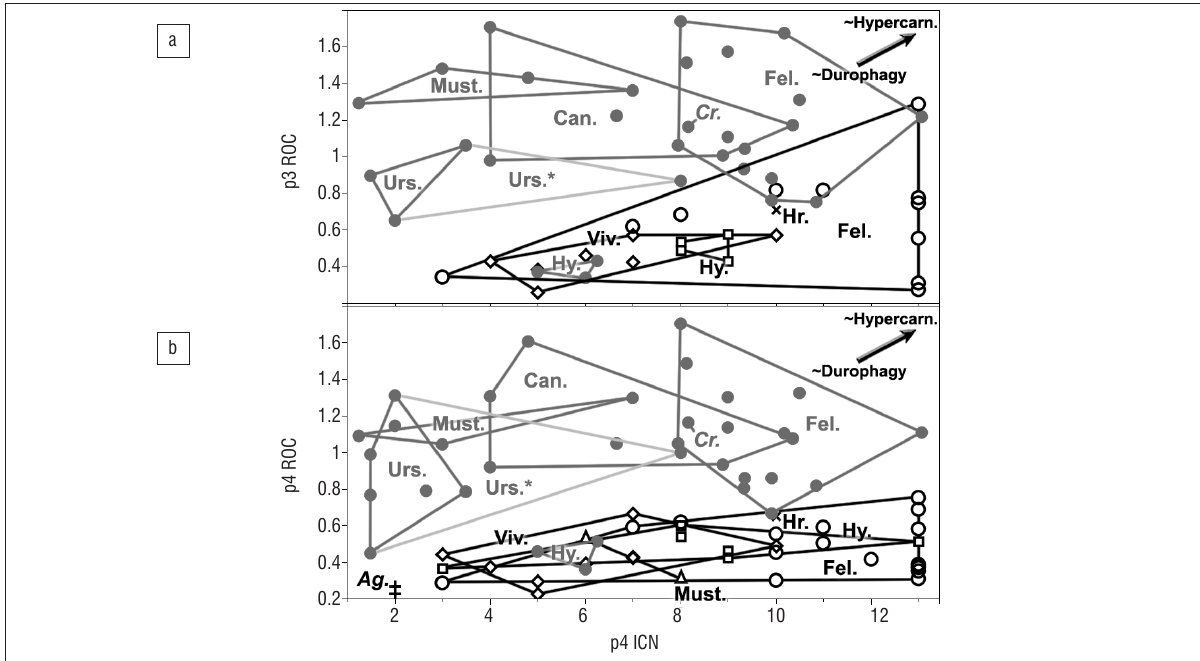
Extant taxa are represented by solid grey circles, Langebaanweg (LBW) canids are represented by asterisks, LBW felids by open circles, LBW hyaenids by open squares, LBW mustelids by open triangles, LBW ursids ( Agriotherium ) by ‘+’ signs, the single analysed LBW herpestid by an ‘x’ sign, and LBW viverrids by open diamonds. Points for the modern families (represented in grey) are for species averages, while points for the LBW sample represent individual specimens as the fossil samples clearly include multiple taxa within each family. Lines delineate minimum convex units for each family: Can., Canidae; Fel., Felidae; Hr., Herpestidae; Hy., Hyaenidae; Must., Mustelidae; Urs., Ursidae; Viv., Viverridae. The individual taxa Agriotherium and Cryptoprocta are denoted ‘Ag’ and ‘Cr.’, respectively. ‘Urs.*’ denotes the Ursid morphospace if the unique Ailuropoda (connected by lighter lines) is included with its confamilials. Figure 11: Dental geometry morphospace of fourth premolar intercuspid notch (p4 ICN) relative to (a) third (p3 ROC) and (b) fourth premolar radii-of- curvature (p4 ROC). As discussed by Hartstone-Rose 1 and Hartstone-Rose and Stynder 3 , modern taxa falling toward the top right of the plot tend toward hypercarnivory and taxa falling toward the bottom left of the plot tend toward durophagy with osteophages generally falling low on the ROC scale and omnivores (particularly those with greater dental heterogeneity) falling further to the left on the ICN